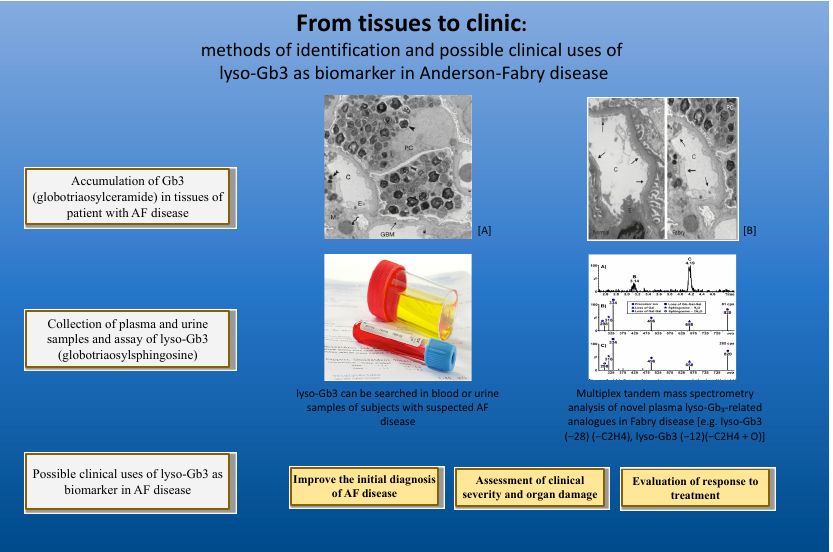
Figure 2. The deacylated form of Gb3, globotriaosylsphingosine (lyso-Gb3), was recently identified as a strong biomarker of Fabry disease. Lysogb3 accumulation can be identified in organs and tissues and can be easily quantified in plasma and urine samples of patients with suspected or documented Fabry disease.( A ) Globotriaosylceramide (Gb-3) inclusions from the kidney biopsy of a Fabry patient [18]; ( B ) comparison of capillary endothelial coverage in kidney biopsies from a normal subject and a Fabry patient